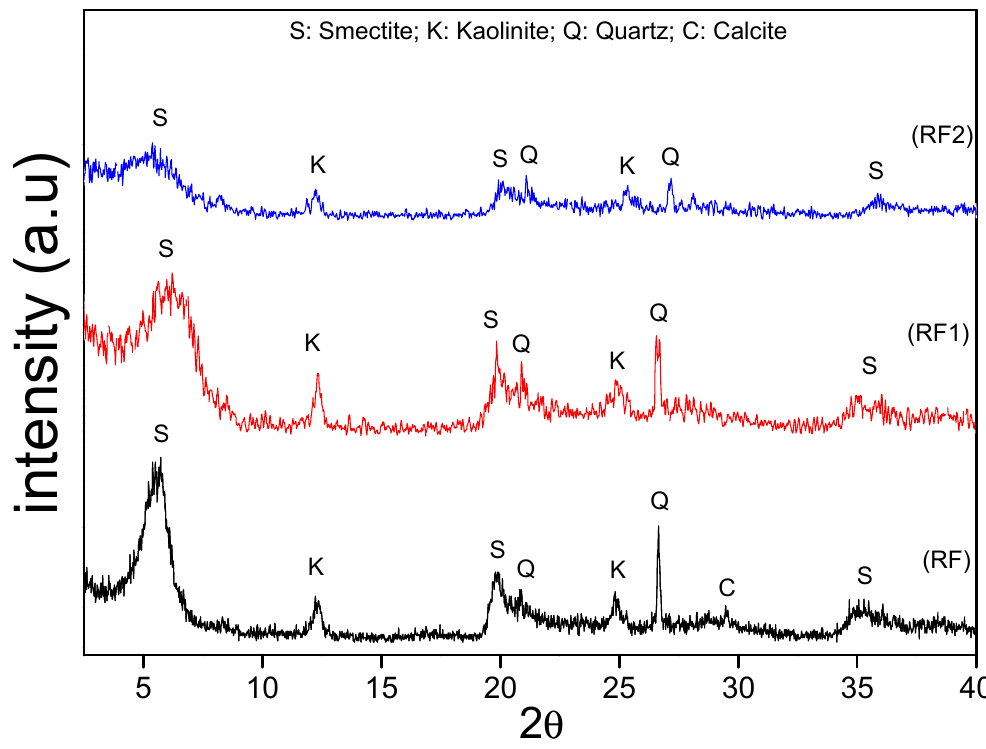
Figure 1. X-ray di ff ractograms obtained from the RF, RF1, and RF2 Figure 1. X-ray diffractograms obtained from the RF, RF1, and RF2 clays.